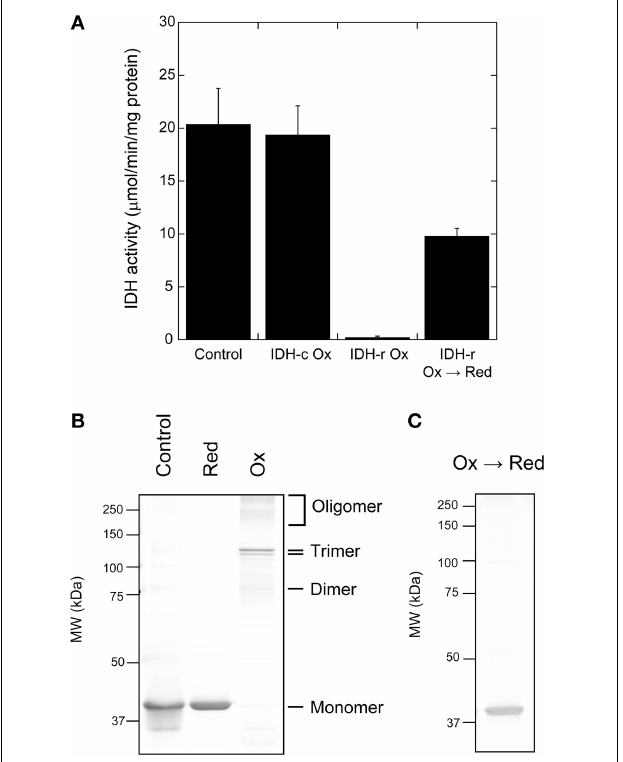
FIGURE 2 | Redox regulation of Arabidopsis IDH recombinant protein. (A) Redox-dependent change in IDH activity. For oxidation (Ox) treatment, IDH-r or IDH-c was incubated in 50 μ M CuCl 2 for 15min. For re-reduction (Ox → Red) treatment, IDH-r after Ox treatment was incubated in 50mM DTT for 30min. Each value represents the mean ± SD ( n = 4). (B) Non-reducing SDS-PAGE profiles of IDH-r after reduction (Red) treatment (5mM DTT for 15min) or Ox treatment. (C) Non-reducing SDS-PAGE profiles of IDH-r after Ox → Red